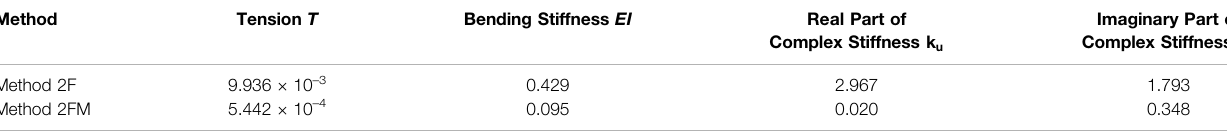
TABLE 4 | RMSER of estimation results for high-damping rubber damper in numerical veri fi cation.